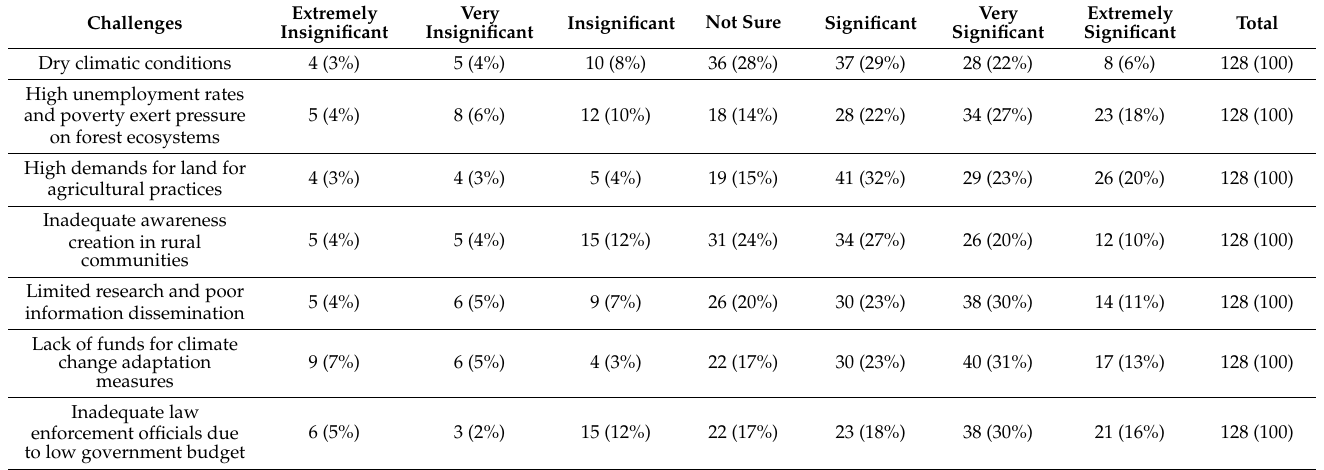
Table 4. Challenges facing the implementation of policy instruments for climate change adaptation in mopane woodland in northern